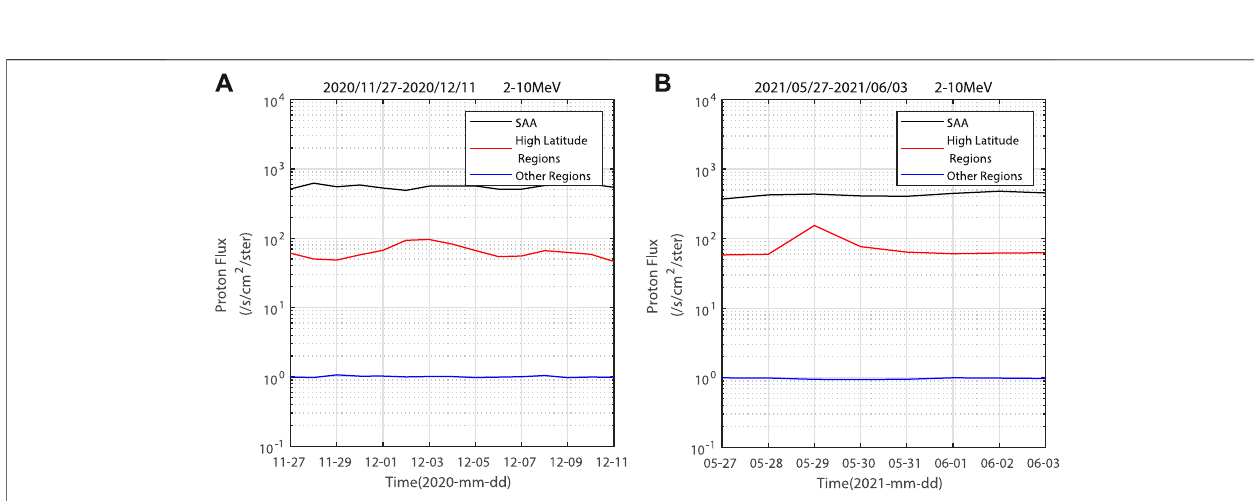
FIGURE6 | Dailyvariation ofproton fl uxes in different regions during theSPEs. The black linerefers to theSAA region, thered linerefers tothe high latituderegion, and the blue line refers to the other regions.